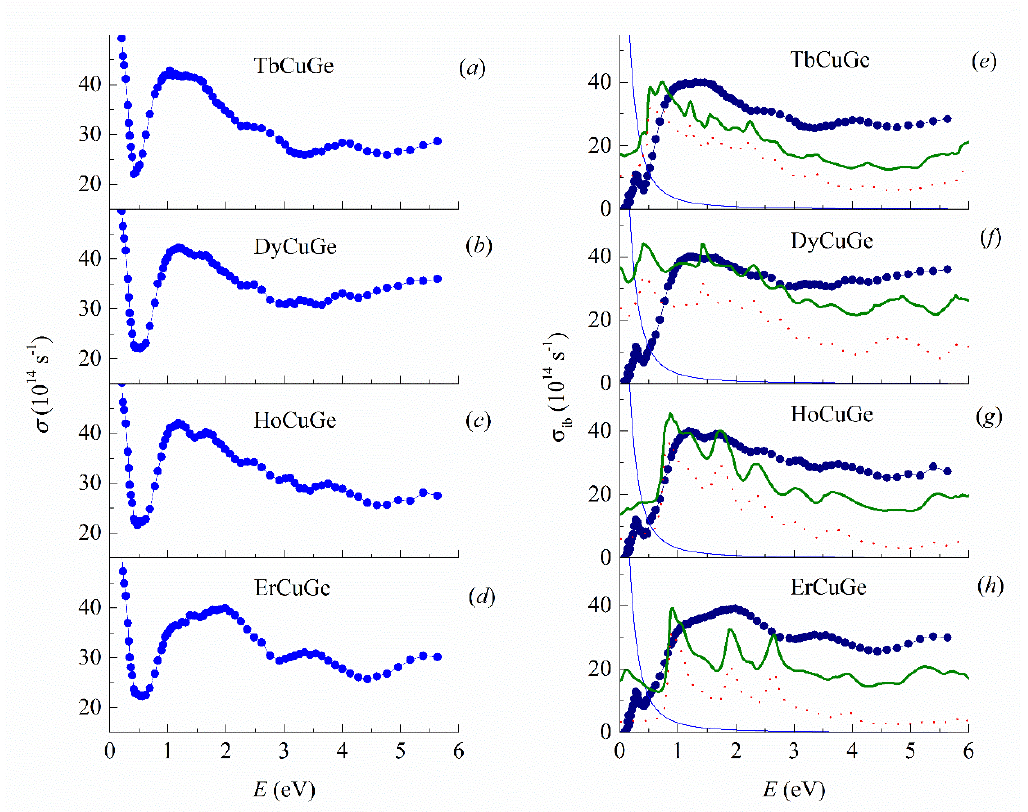
Figure 4. Optical constants n and k depending on wavelength λ  for ( a ) TbCuGe, ( b ) DyCuGe, ( c ) HoCuGe and ( d ) ErCuGe. Dependencies of real part of dielectric permeability ε 1 and reflectivity R depending on photon energy E for ( e ) TbCuGe, ( f ) DyCuGe, ( g ) HoCuGe and ( h ) ErCuGe.